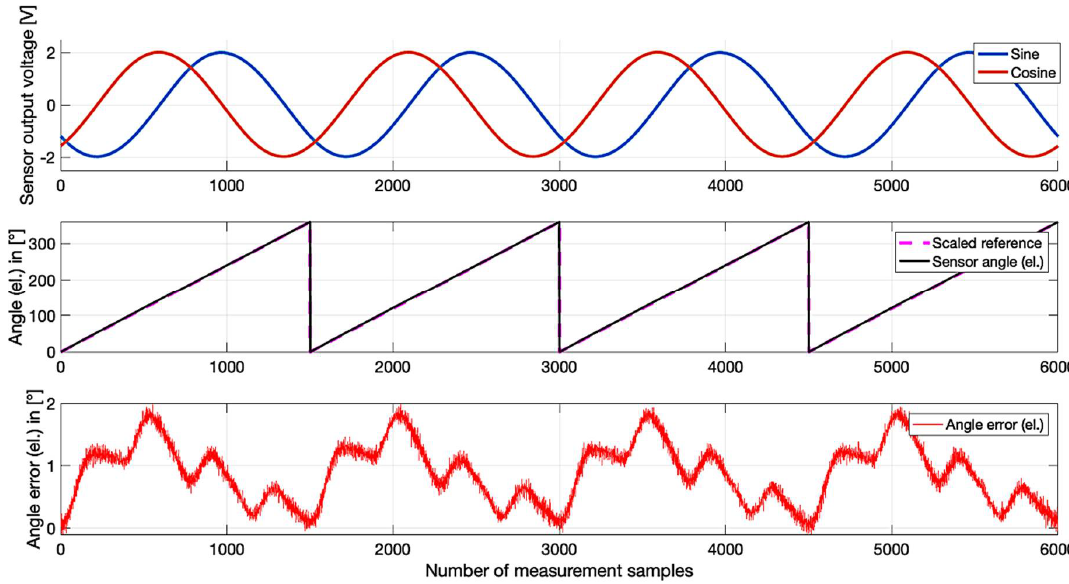
Figure 20. Measurement and processed signals of the Inductive Sample #4 at n = 4000 rpm and RT.